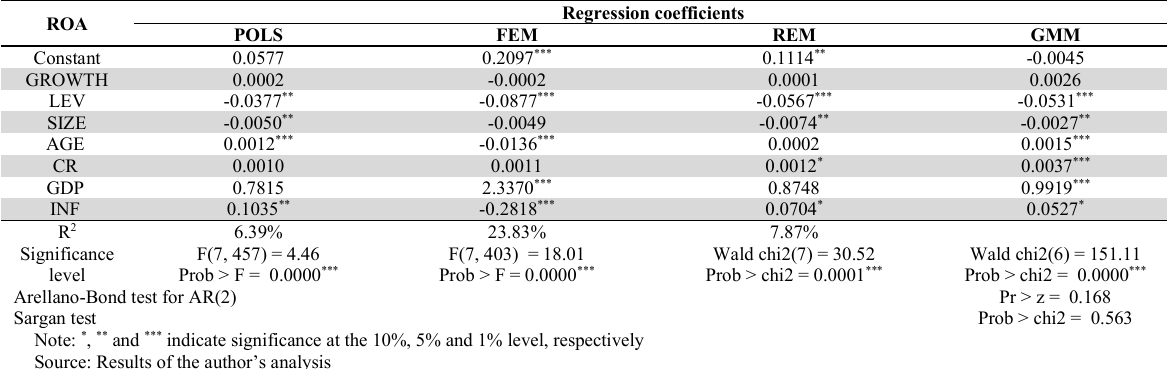
Results of research